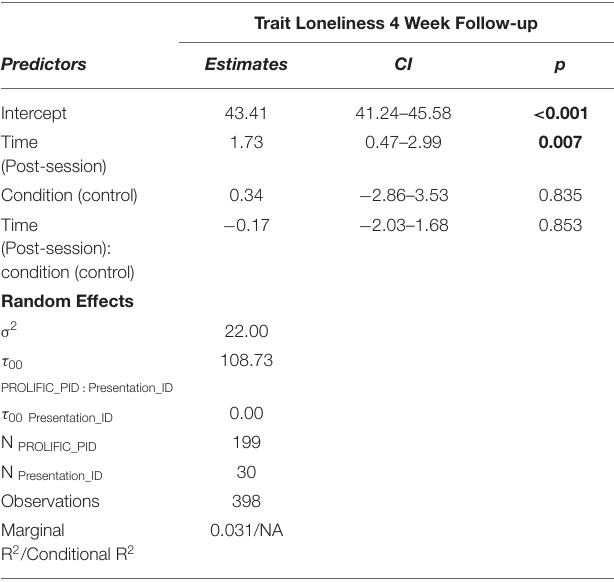
TABLE 3 | Trait loneliness did not differ between before the presentation and 4 weeks after the presentation to a different extent across conditions. Trait Loneliness 4 Week